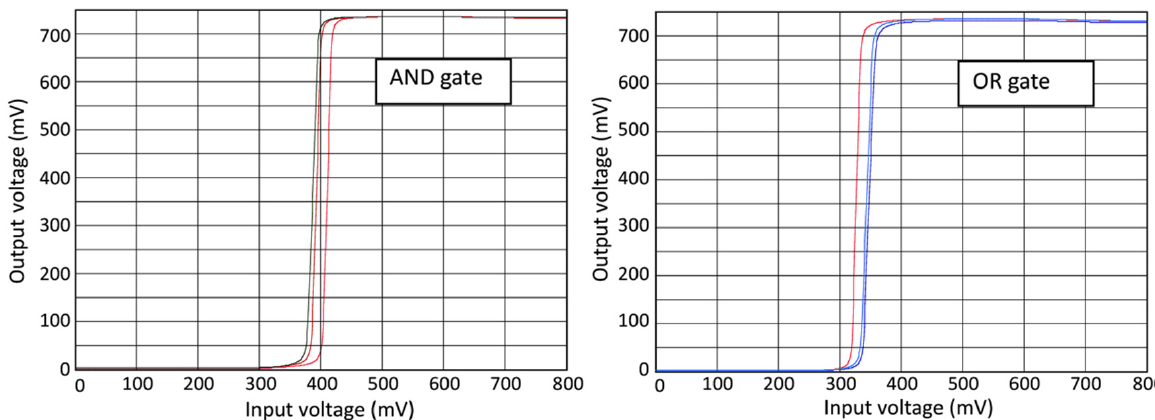
Figure 15. Transfer characteristics of AND and OR gates. V CC = 1 V, R = 500 k Ω , temperature 300 K. AND: All three characteristics are almost the same. OR: All three characteristics are almost the same.